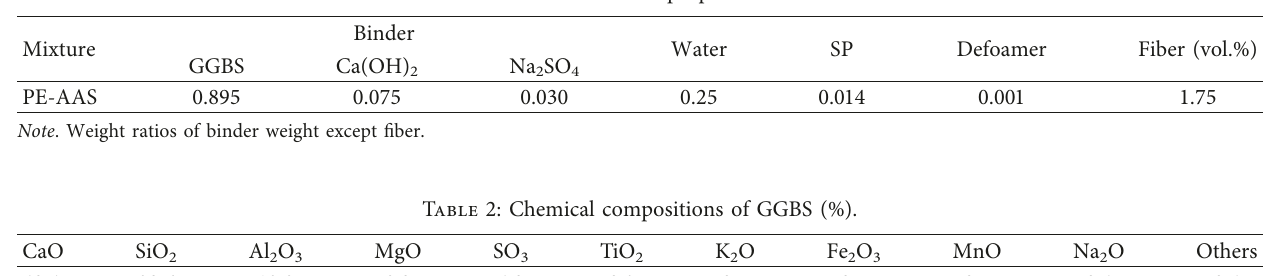
Table 1: Mixture proportions.